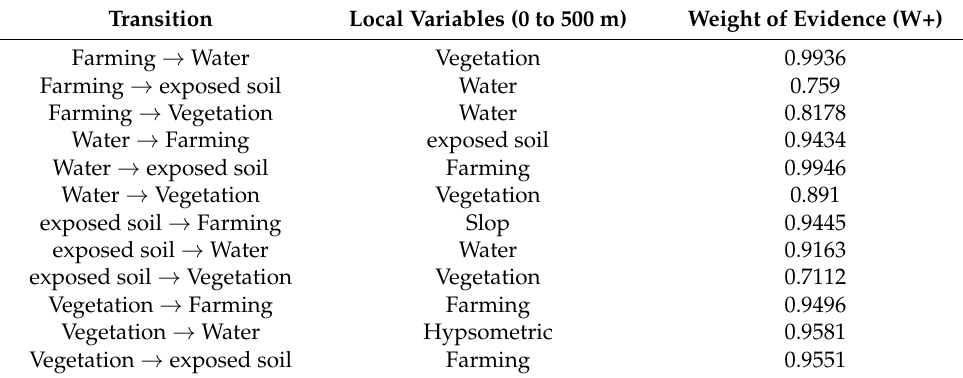
Table 2. Continuous and static variables that most influenced land use and land cover transitions in the municipality of Floresta-PE.